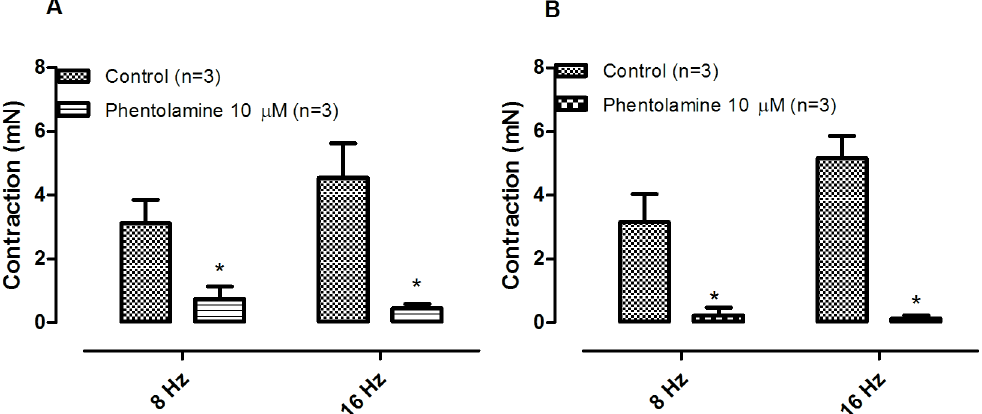
Fig 1. Effect of phentolamine (10 μ M) on EFS-inducedcontractions on corpora cavernosa isolated from Crotalus (A) and Rabbit (B) . Data are expressedas mean ± standarderror mean (S.E.M) pairedStudent’st test, * P < 0.05 vs